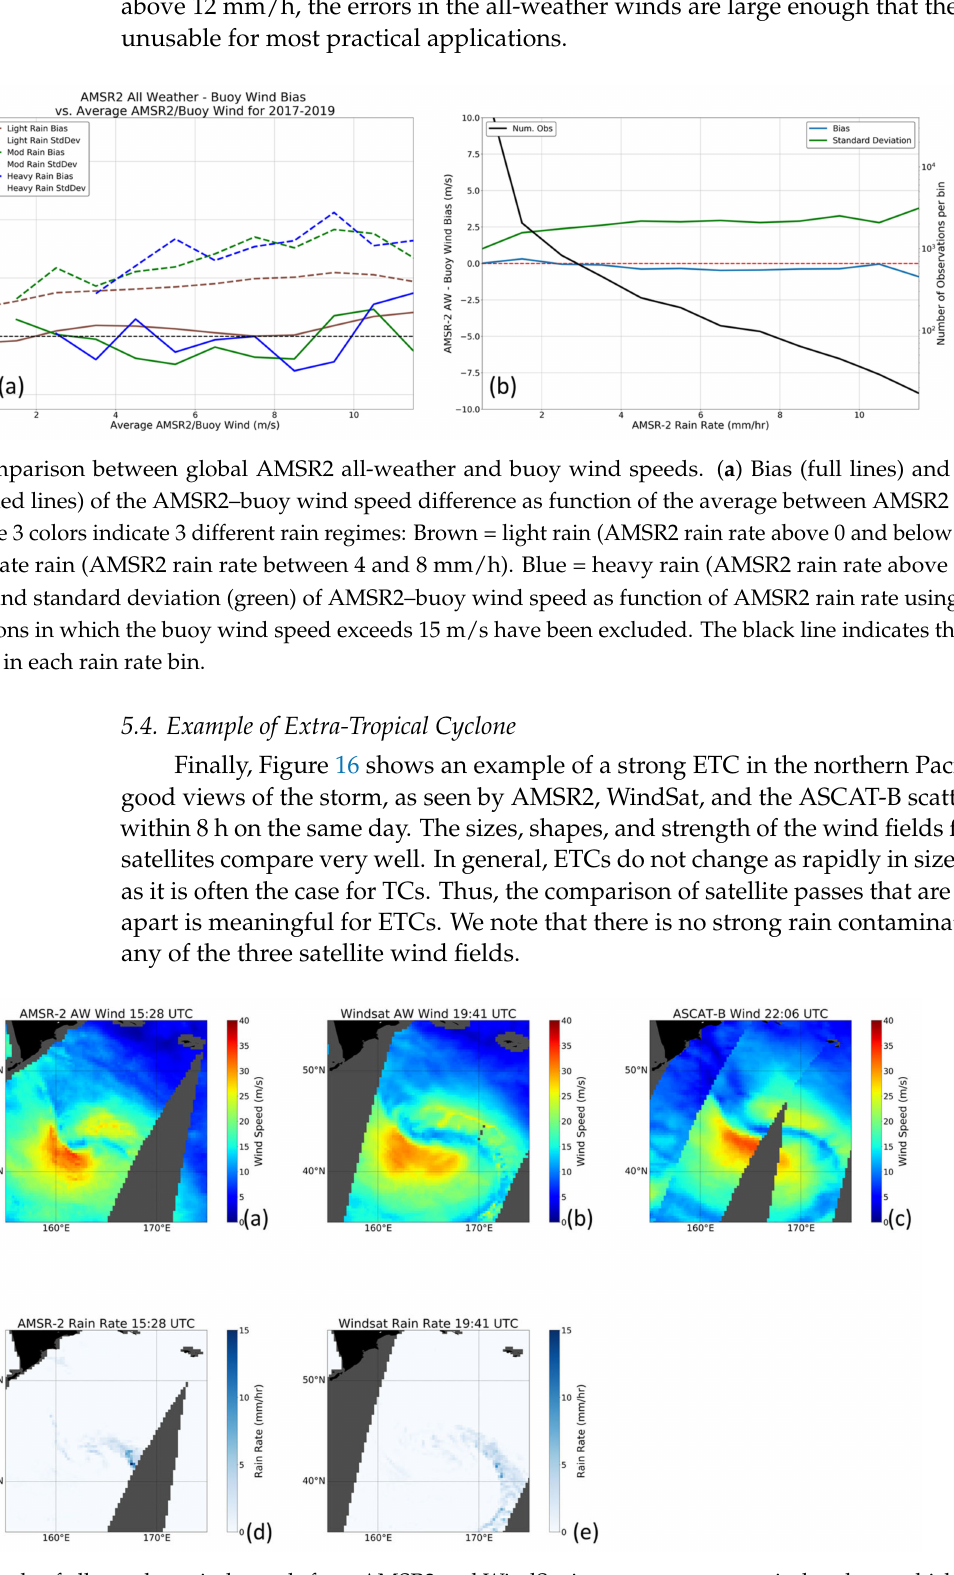
Figure 16. Example of all-weather wind speeds from AMSR2 and WindSat in a strong extra-tropical cyclone, which occurred on 12/24/2018 in the northern Pacific. ( a ) AMSR2 all-weather wind. ( b ) WindSat all-weather wind. ( c ) For comparison we show the wind from the ASCAT-B scatterometer processed by the RSS algorithm [95]. ( d ) AMSR2 rain rate. ( e ) WindSat rain